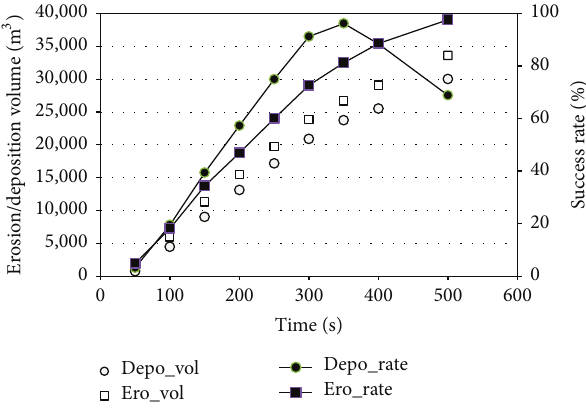
Figure 11: Variation of erosion/deposition volume and its success